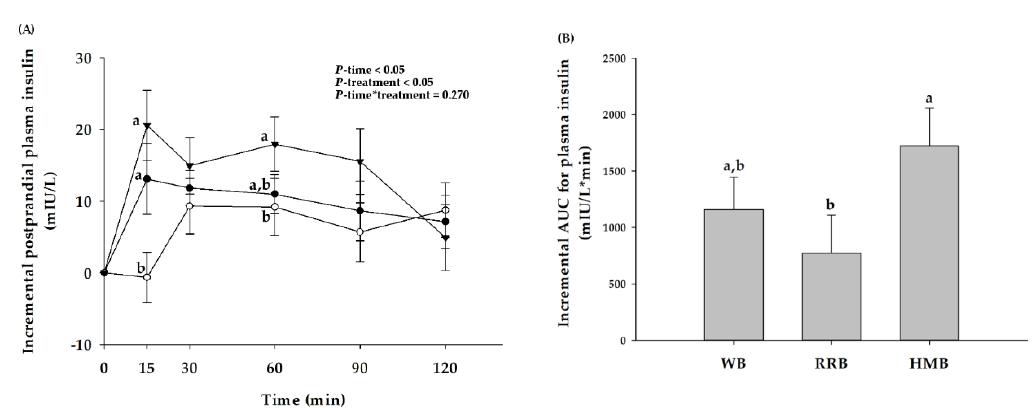
Figure 5. ( A ) Changes in postprandial insulin concentration and ( B ) the iAUCs for plasma insulin of healthy participants after the consumption of wheat bread (WB), Riceberry rice bread (RRB), and Hom Mali bread (HMB). All values are means ± SEM, n = 16. WB (●), RRB ( ○ ), and HMB ( ▼ ). For each time point, means with a different letter are significantly different, p < 0.05.